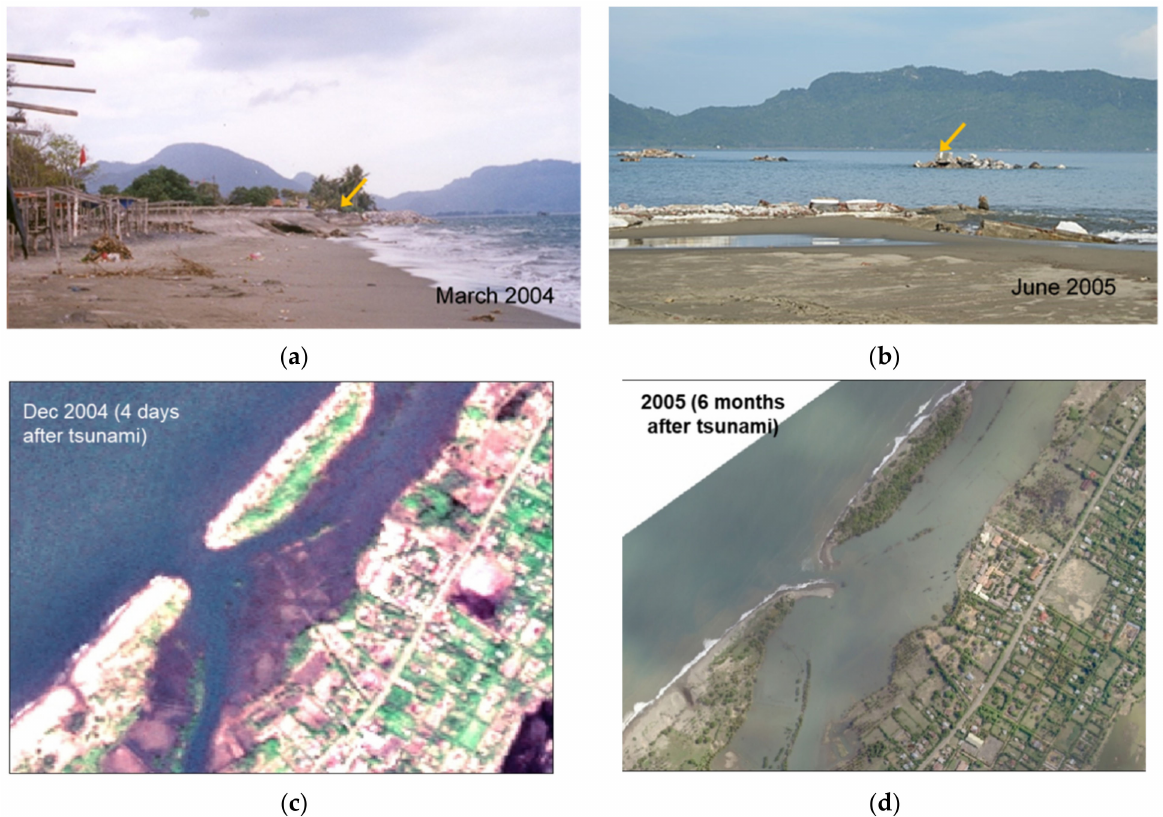
Figure 2. Indication of land subsidence at Lambadeuk, southwest of Banda Aceh coast: ( a ) The revetment located at the upper shoreface to protect the coast from further erosion nine months before the tsunami hit the coast on 26 December 2004; ( b ) The remnant of a seawall post-tsunami. The yellow arrows in both pictures show the same revetment; ( c ) The breaching of barrier island at Kuala Gigieng four days after the tsunami; ( d ) The development of sand spit growth six months after the tsunami, to reconnect the breached barrier islands at Kuala